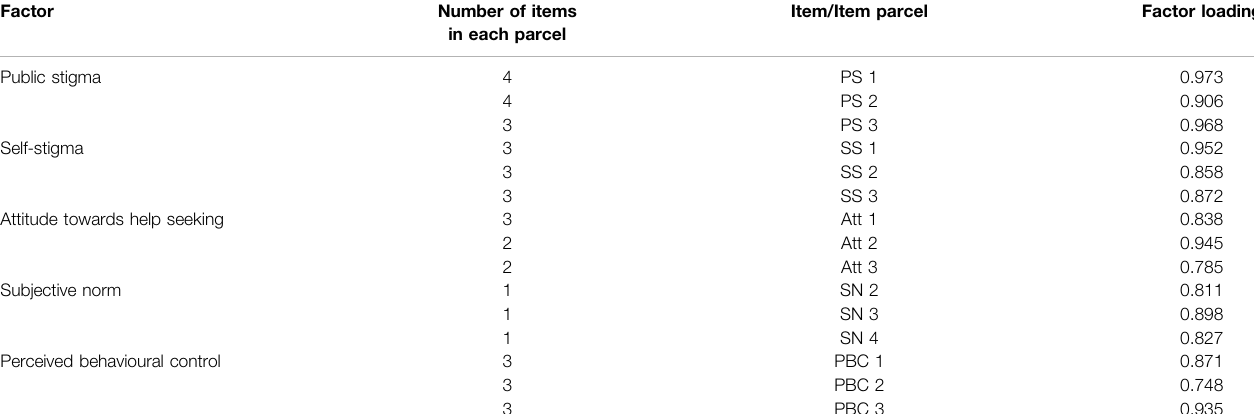
TABLE 1 | Factor loadings for all items or item parcels and their respective latent construct. Factor